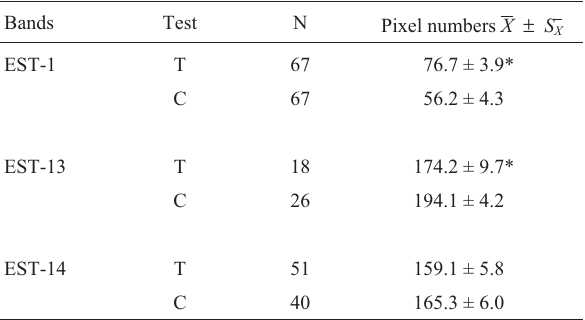
Table5 -EffectofPB-treatmentonesterasebandactivity.Meanvaluesandstandard deviationinpixelsobtainedbyImageAnalysisoftheesterasebandsEST-1,EST-13 and EST-14, in gels prepared with control (C) and PB-pretreated (T) mosquitoes from São José do Rio